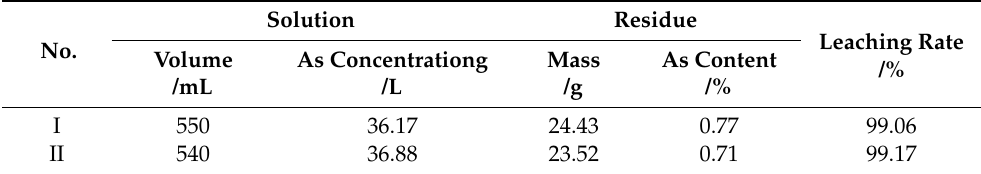
Table 2. Results of verification experiments under selected